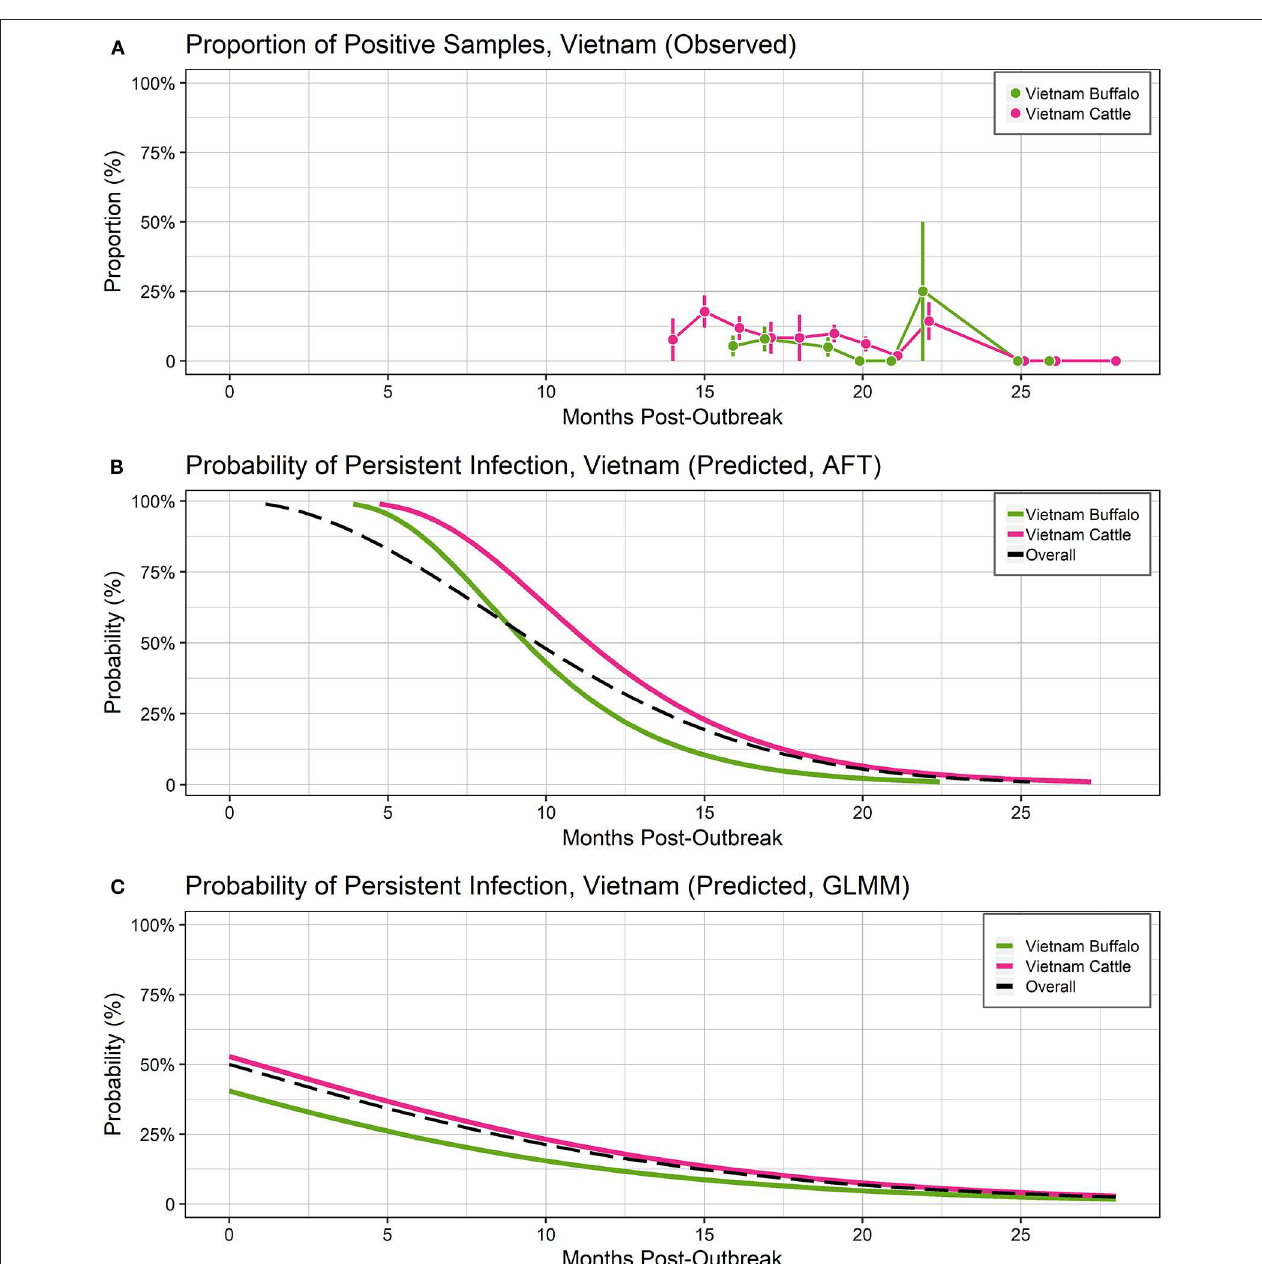
FIGURE 2 | Probability of persistent infection, Vietnam data only. All study animals were seropositive for FMDV anti-NSP antibodies by 3ABC-ELISA. (A) Observed proportion of OPF samples positive for FMDV RNA. Mean and standard error are shown. (B) Predicted probability of persistent infection, AFT model. (C) Predicted probability of persistent infection, GLMM